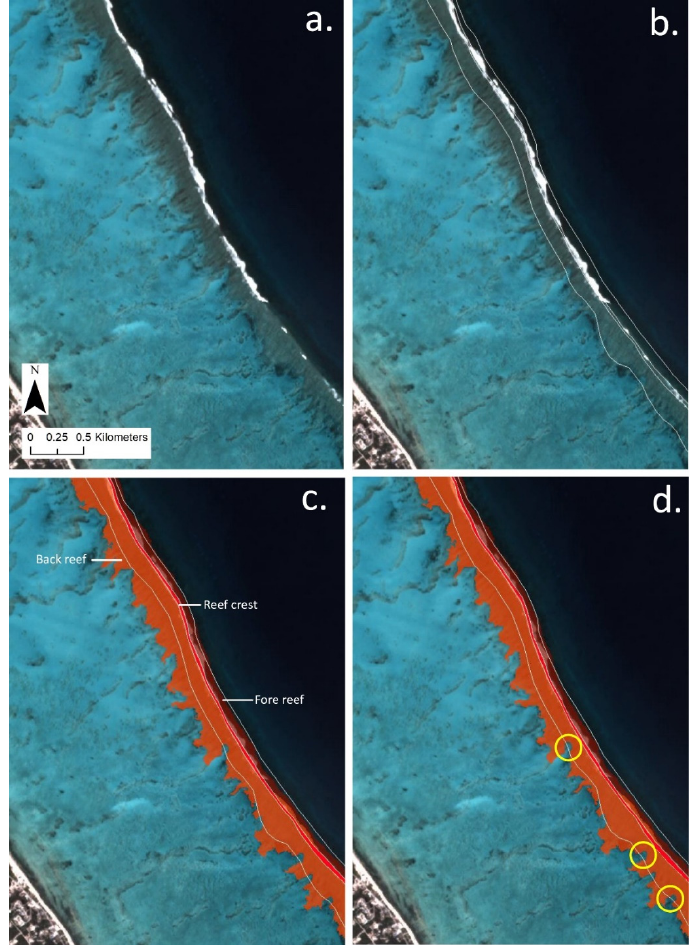
Figure 9. Mapping of the reef crest and back and fore reefs: ( a ) PS imagery showing the lagoon area and reef crest separating the deep ocean boundary; ( b ) Polygon boundary of the geomorphic zone overlaid onto the imagery that identifies the reef crest area and is used in the parental guidance technique to refine the reef type boundaries; ( c ) Classification of reef crest (red), fore reef (brown), and back reef (orange) using the parental guidance approach; ( d ) Comparison to the polygon boundary differences indicating the improvement of reef type mapping using the parental guidance technique. Yellow circles highlight areas where the back reef has expanded and where sandy areas have contracted.